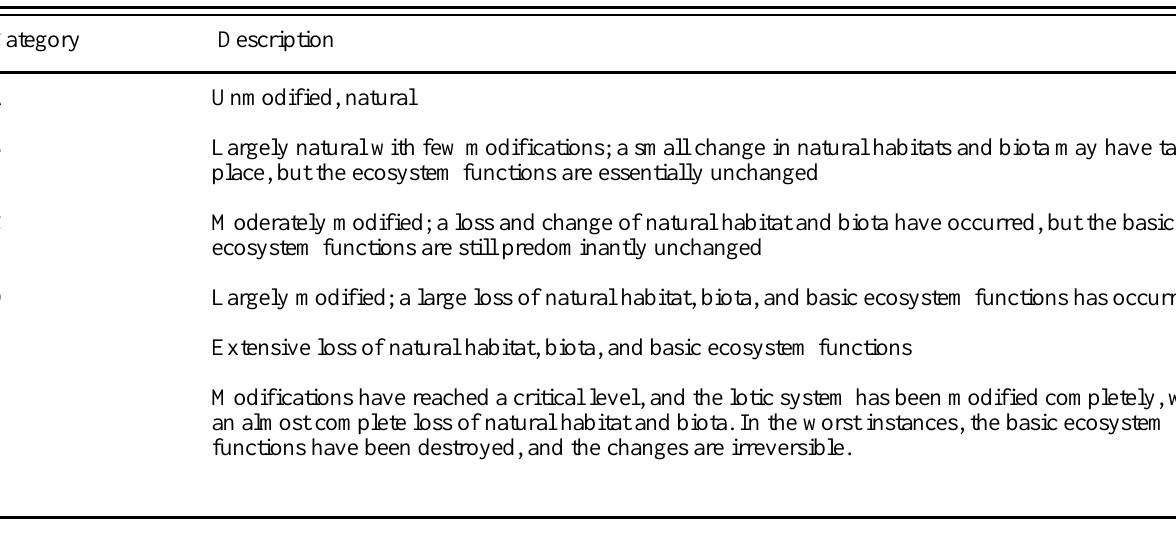
Table 8 . Ecological status categories (from Kleynhans